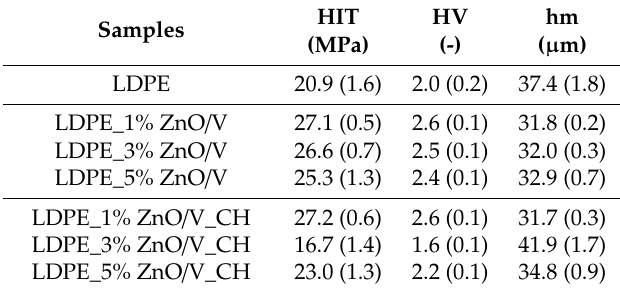
Table 4. The average values of the LDPE plate microhardness (HIT—indentation hardness; HV—Vickers microhardness; and hm—maximum impression depth). Standard deviations are provided in